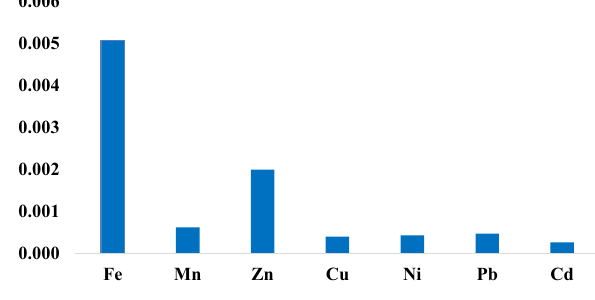
Fig. 5 Estimated daily intake (EDI) of heavy metals via the